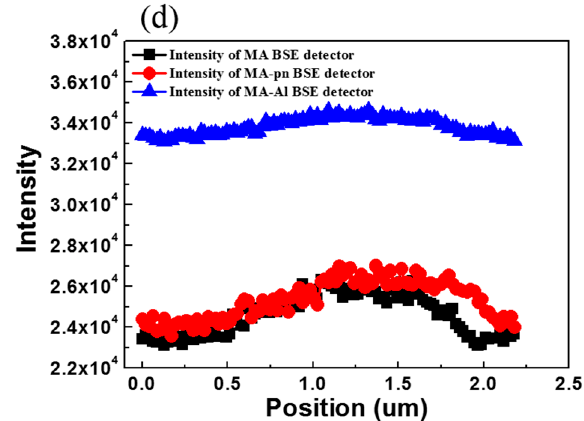
Figure 11. BSE Images of the selected gold particle recorded with ( a ) MA BSE detector, ( b ) MA p-n BSE detector and ( c ) MA-Al detector. ( d ) The intensity profiles across the gold particle of different BSE detectors.